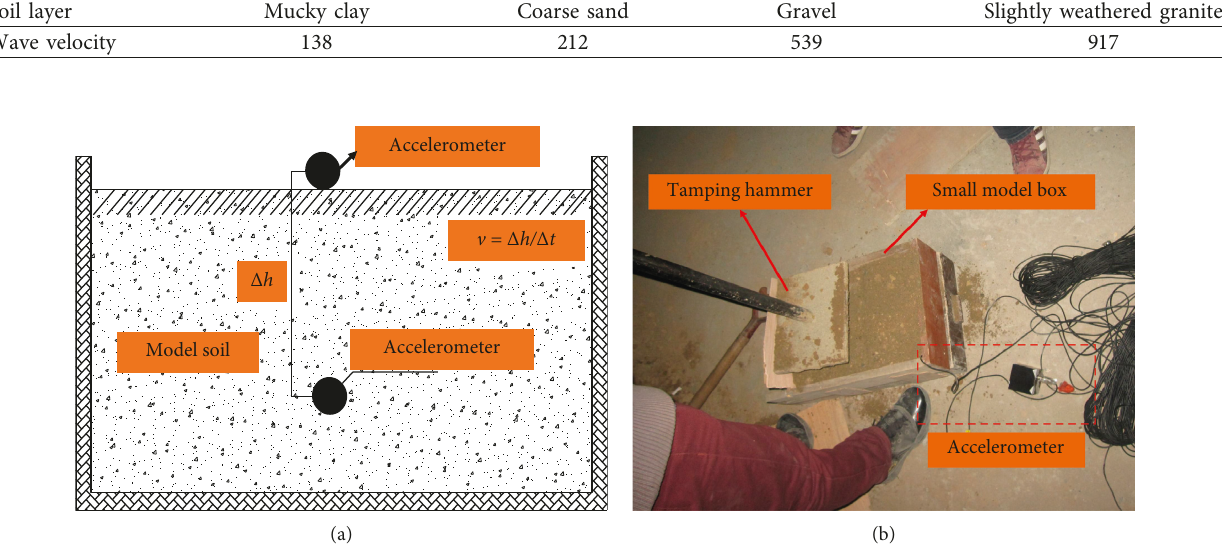
Figure 6: Shear wave velocity method: (a) sketch map and (b) specific implementation.